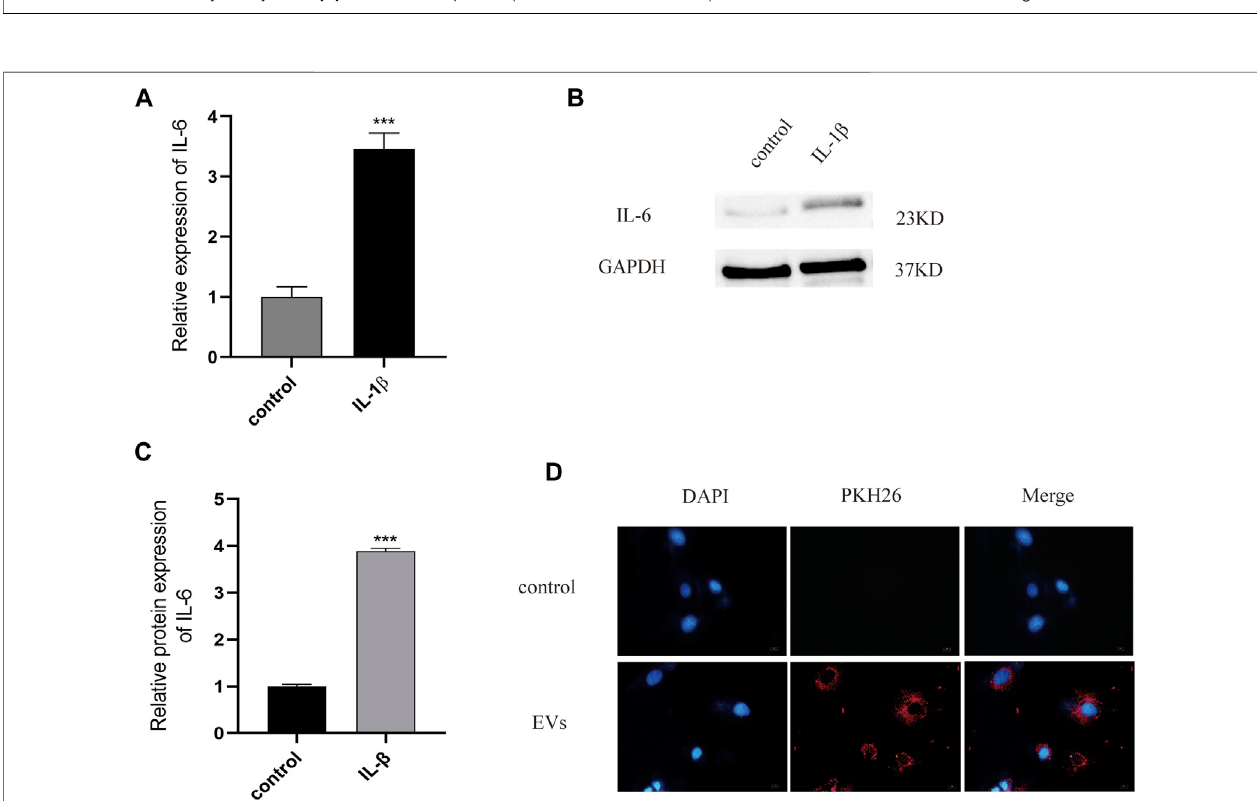
FIGURE 2 | (A) The expression of in fl ammatory factor IL-6 analyzed by Elisa. (B) and (C) The protein of IL-6 measured by western blot. (D) PKH26-labeled were uptaked by chondrocyte. Scale bar (cid:2) 10 μ m, n (cid:2) 3, *** p < 0.001, t-test for all.